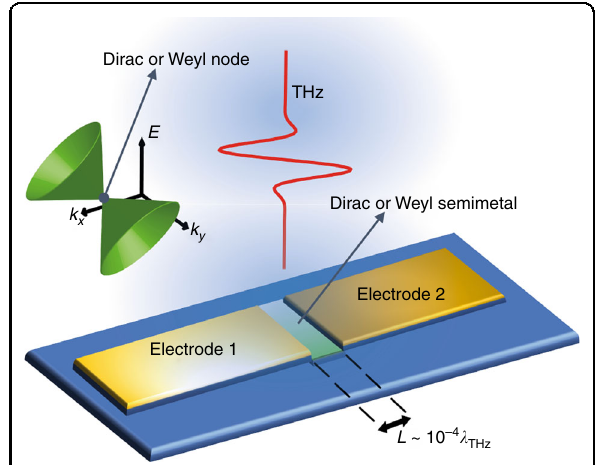
Fig. 1 Schematic of the in-plane asymmetric device enabling an ef fi cient low-energy photodetection. The THz near- fi eld is concentrated into the nanogap of thickness L , where the type-II Dirac or Weyl semimetal